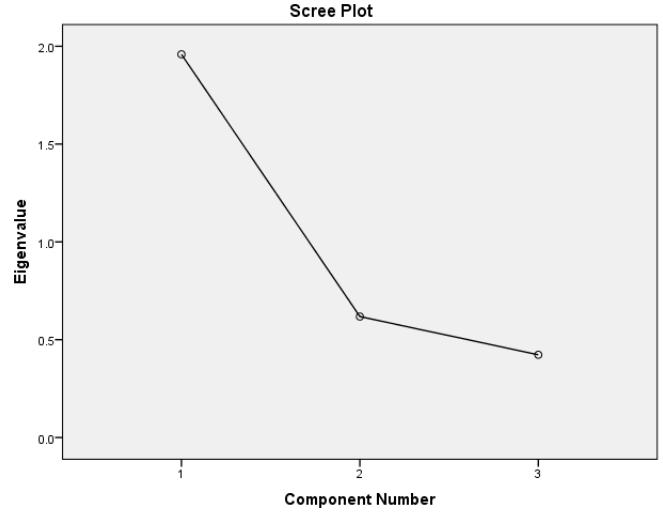
Figure 3. Sedimentation graph of the competence of Researcher Training. Source: Authors.